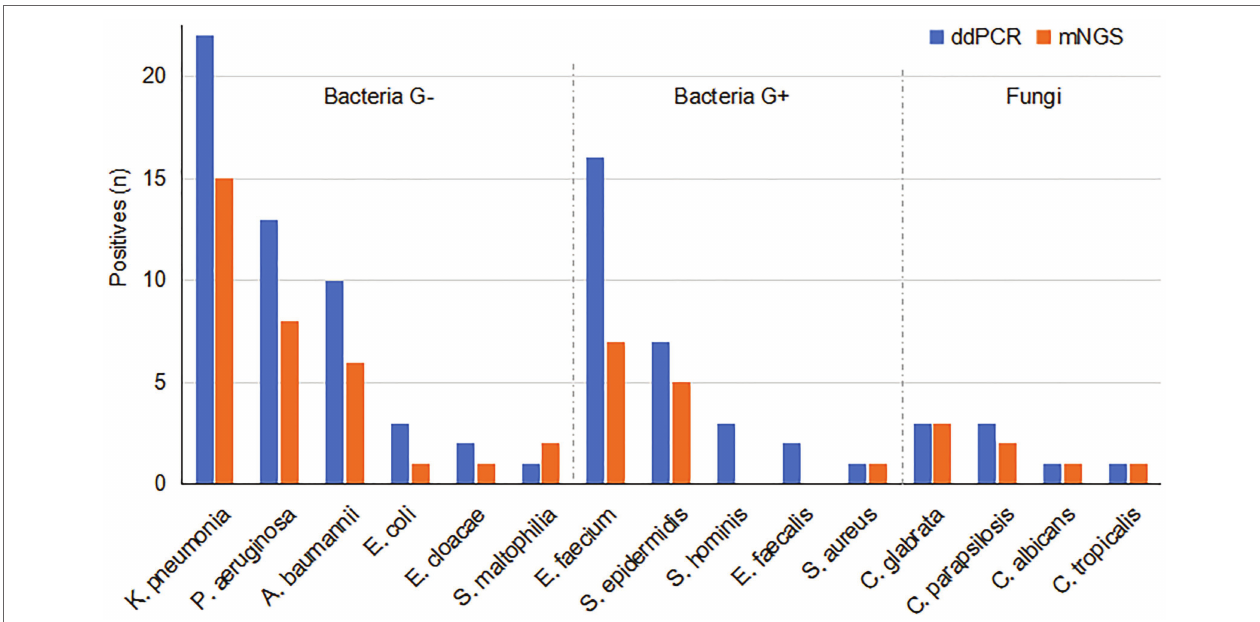
FIGURE 1 | Pathogens detected by droplet digital PCR (ddPCR) and metagenomic next-generation sequencing (mNGS) within the detection range of ddPCR. Blue bars, pathogens detected by the ddPCR method; orange bars, pathogens detected by the mNGS method. ddPCR, droplet digital PCR; mNGS,